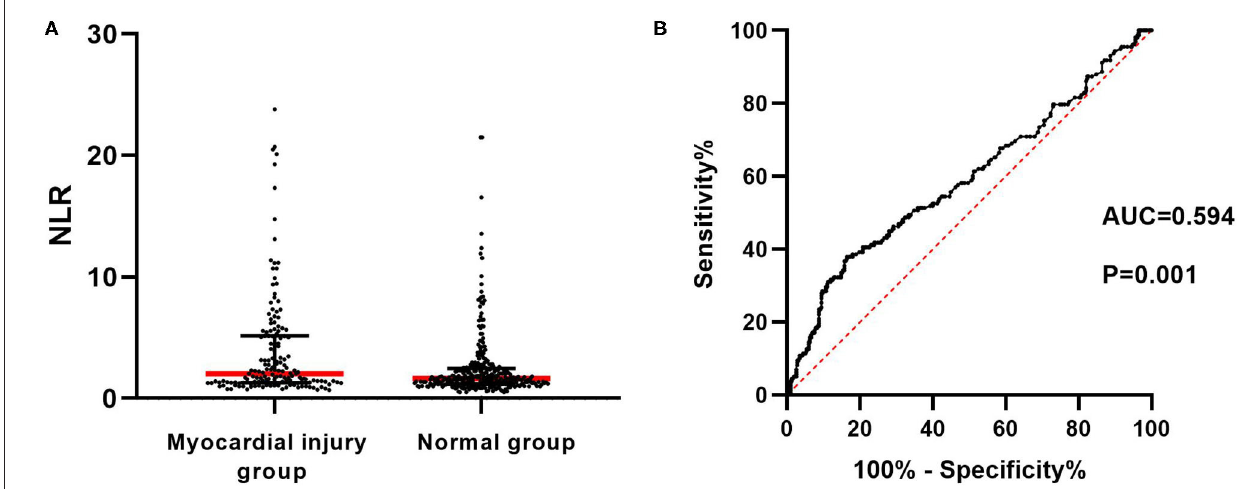
FIGURE 2 | Predictive role of NLR in the occurrence of myocardial injury at high altitude. (A) Scatter plot of NLR values in myocardial injury group and normal group respectively. Red transverse line represents the median in each group. Black transverse line represents the upper and lower quartile in each group. (B) ROC curve revealed that NLR could significantly predict myocardial injury with AUC of 0.594. NLR, neutrophil to lymphocyte ratio; ROC, receiver operating characteristic; AUC, area under the